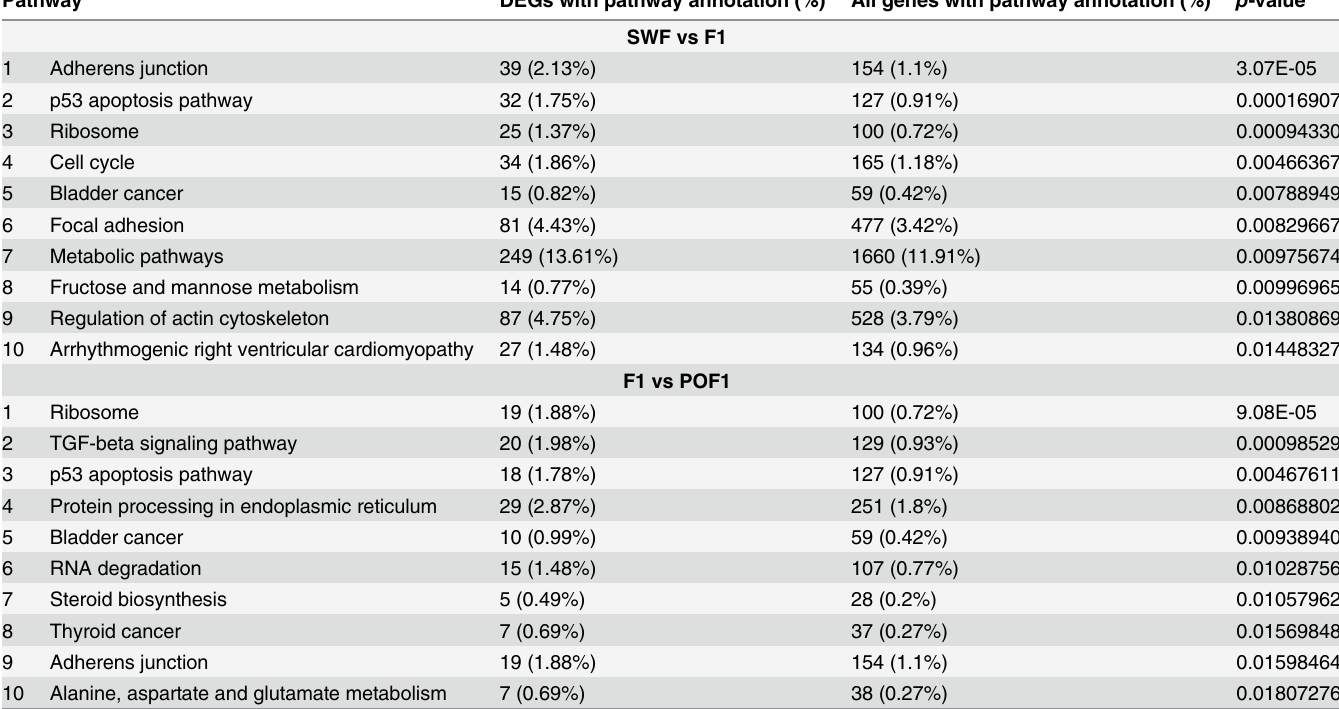
Table 2. Significantly enriched